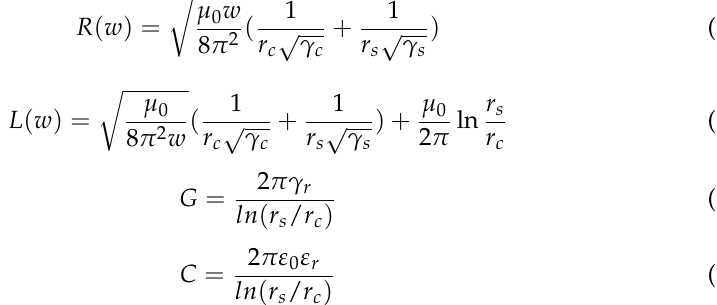
Table 2. The characteristics of 1#–7# simulated cable.